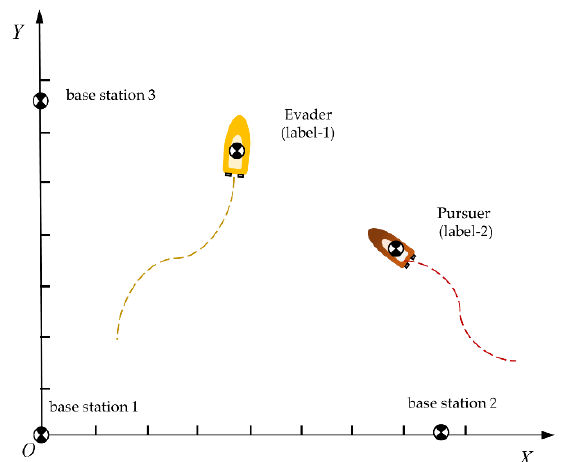
Figure 10. Structure of UWB position measurement system.